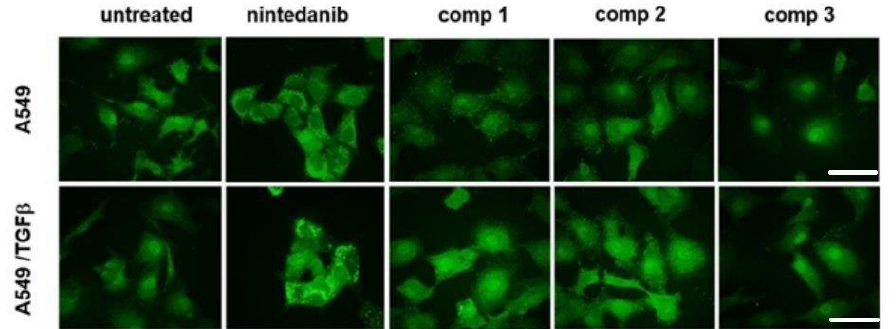
Figure 5. Representative images of fluorescence confocal analysis of A549 and TGF β -treated A549 cells exposed to compounds 1 – 3 or nintedanib (5 µ M) for 24 h. After incubation, cells were fixed and processed for fluorescence confocal imaging (Emission at 580 nm). Image dimensions: 180 × 180 µ m, scale bar 50 µ m. Experiments were performed at least three